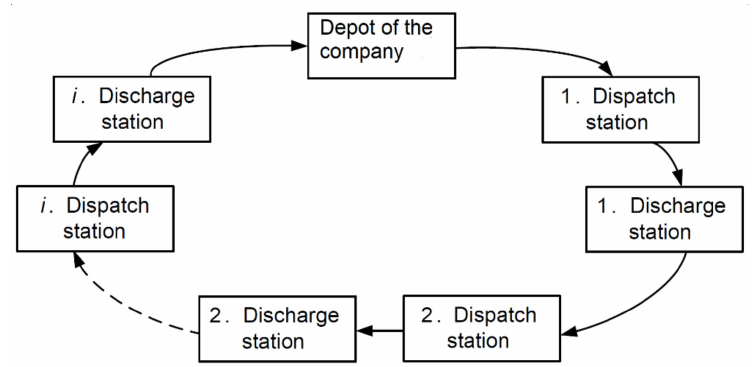
Figure 1. The structure of transport loops.